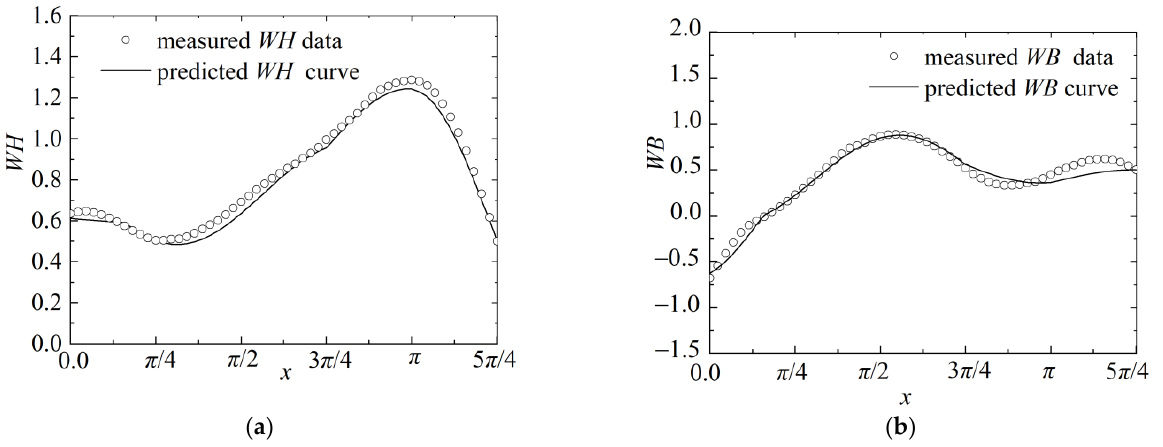
Figure 11. Comparisons of measured complete characteristic curves of pump and predicted complete characteristic data of pump (0 ≤ x ≤ 5 π /4): ( a ) comparison of predicted WH curve and measured WH data; ( b ) comparison of predicted WB curve and measured WB data.